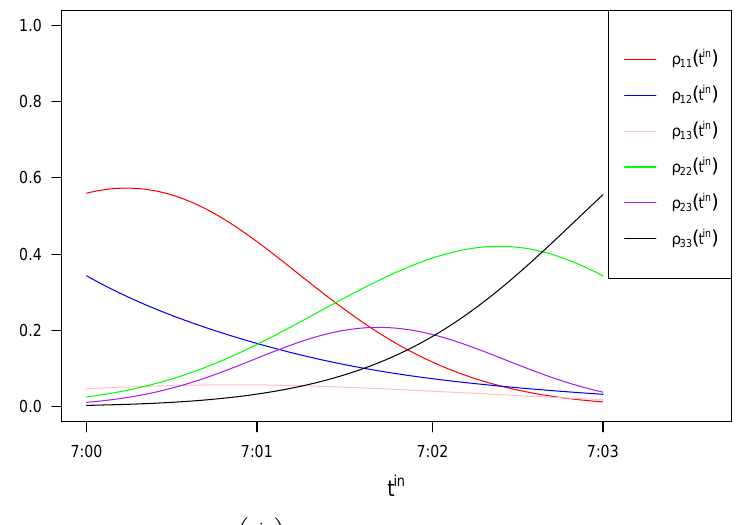
Figure 6. Curves of ρ jk